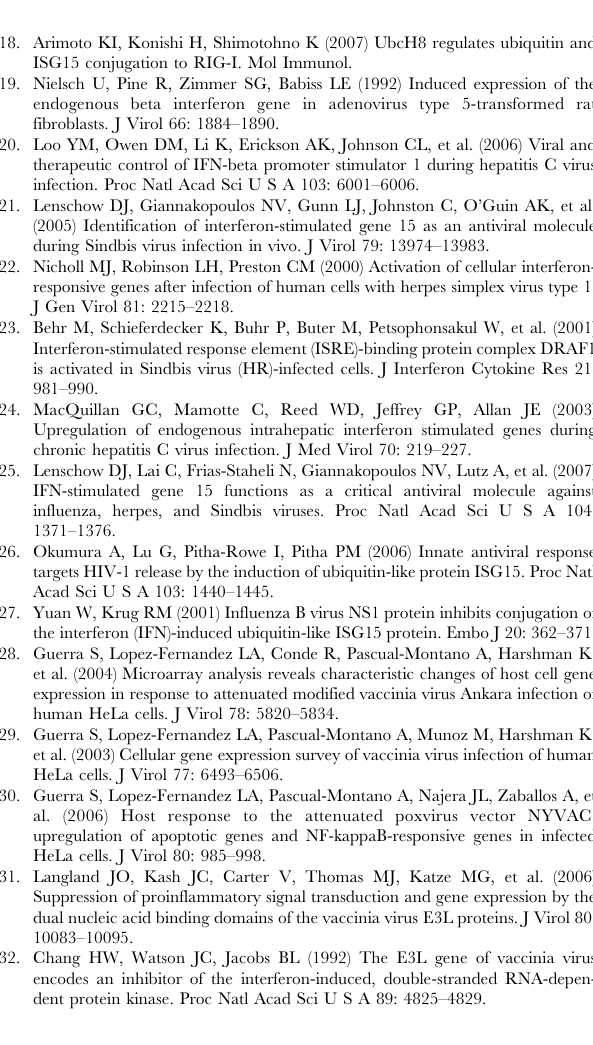
Figure S1 Effect of ISG15 overexpression on virus citotoxicity after infection of MEFs with virulent and E3L deletion VACV mutant viruses. A–B. ISG15 2 / 2 or ISG15 + / + MEFs were transduced with high-titer viral supernatants corresponding to the pISG15-ires-GFP retroviral vector. CPE was visualized by phase- contrast microscopy at the indicated times p.i. Table S1 Levels of ISG15 mRNA detected by quantitative real- time RT-PCR after infection of HeLa cells with several VACV